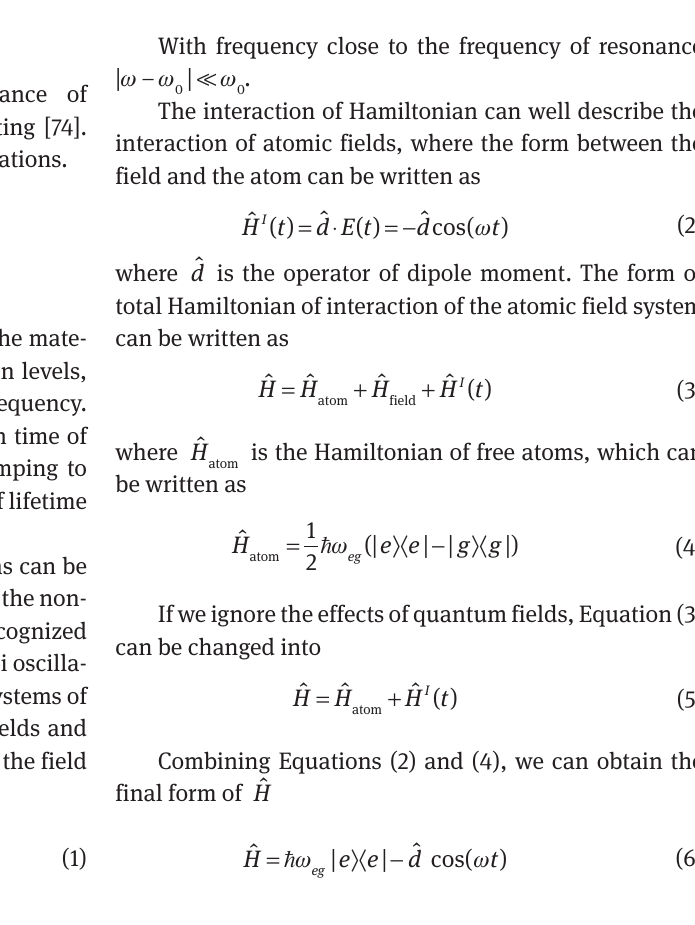
and X . When strong coupling arises, the L M